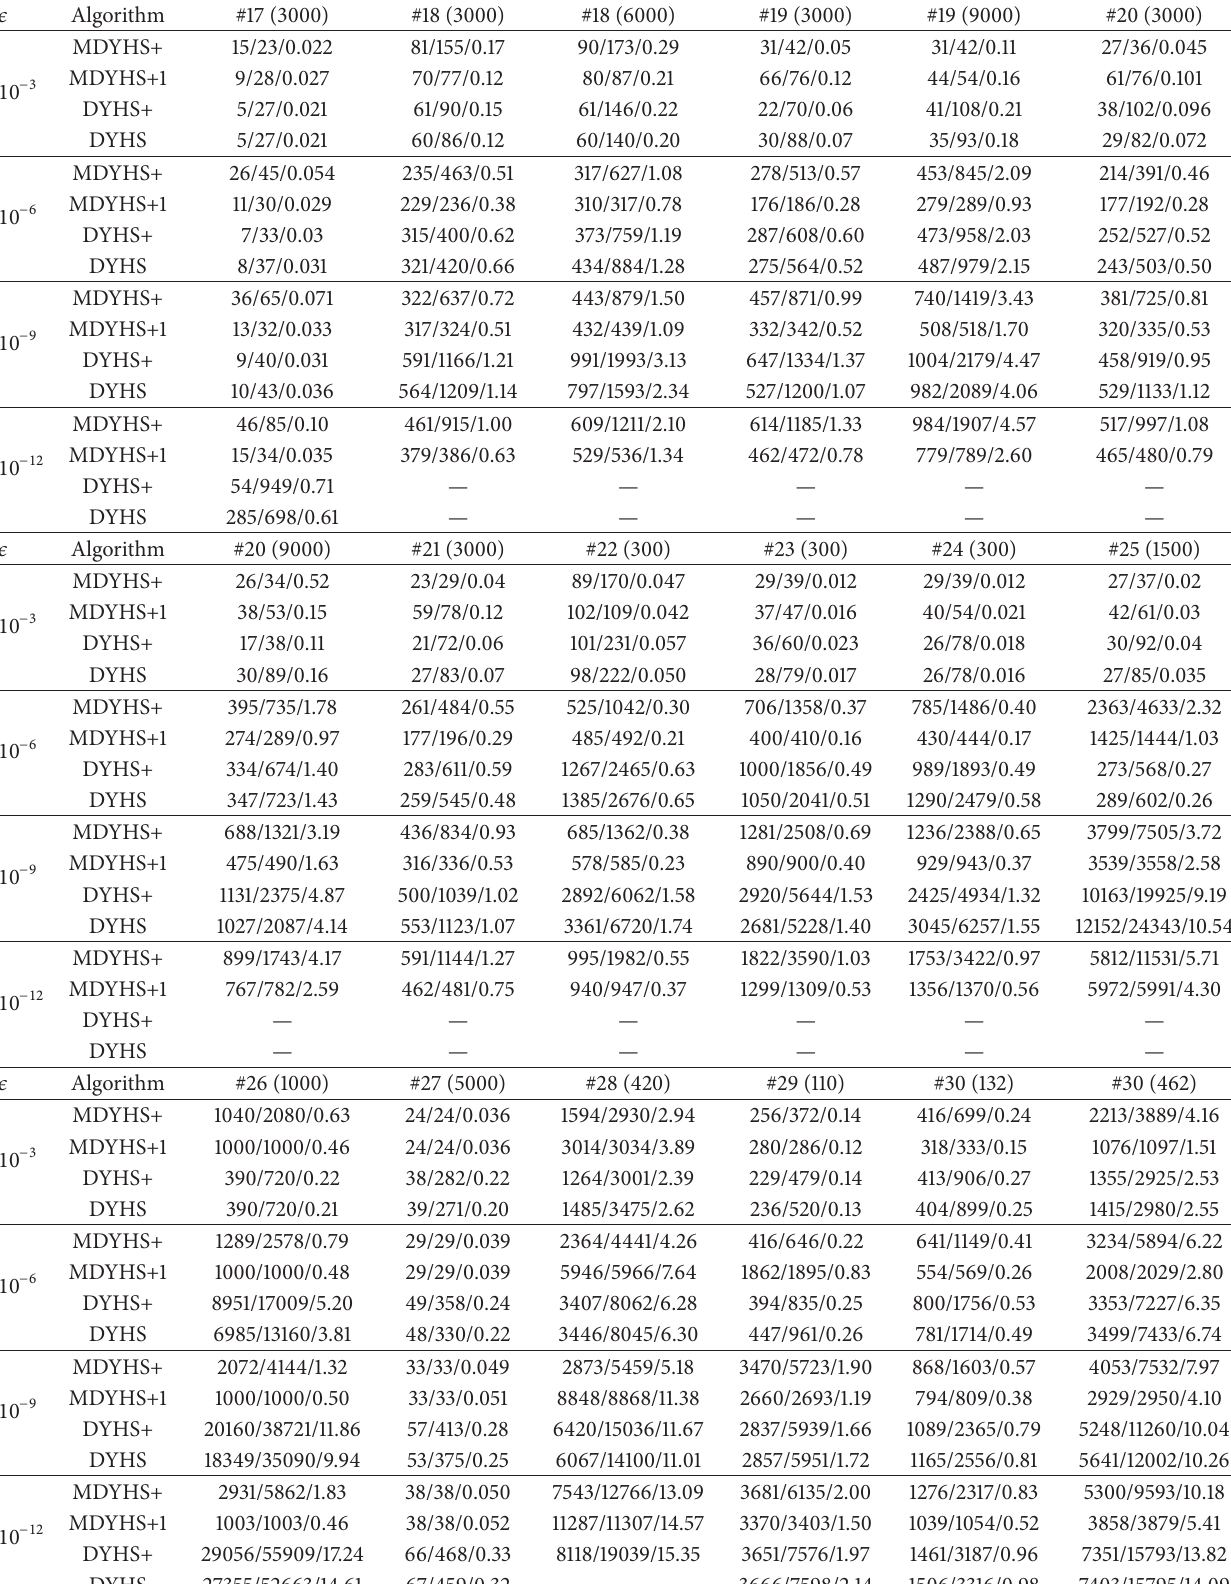
Table 3: Numerical results for test problems from the CUTEr